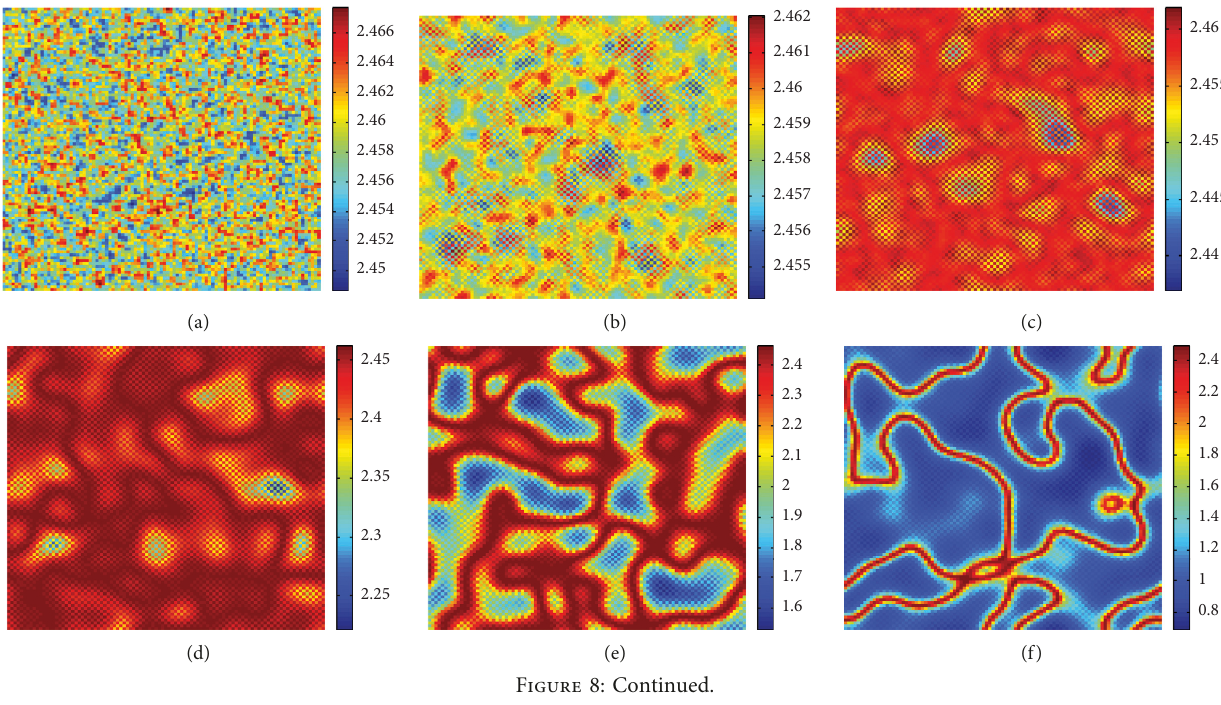
� 1 . 390, d � 0 . 20, q � 0 . 01, τ � 0, h � 1, and ε � 0 . 001. (a) t � 5; (b) t � 25; (c) t � 30; 1 2